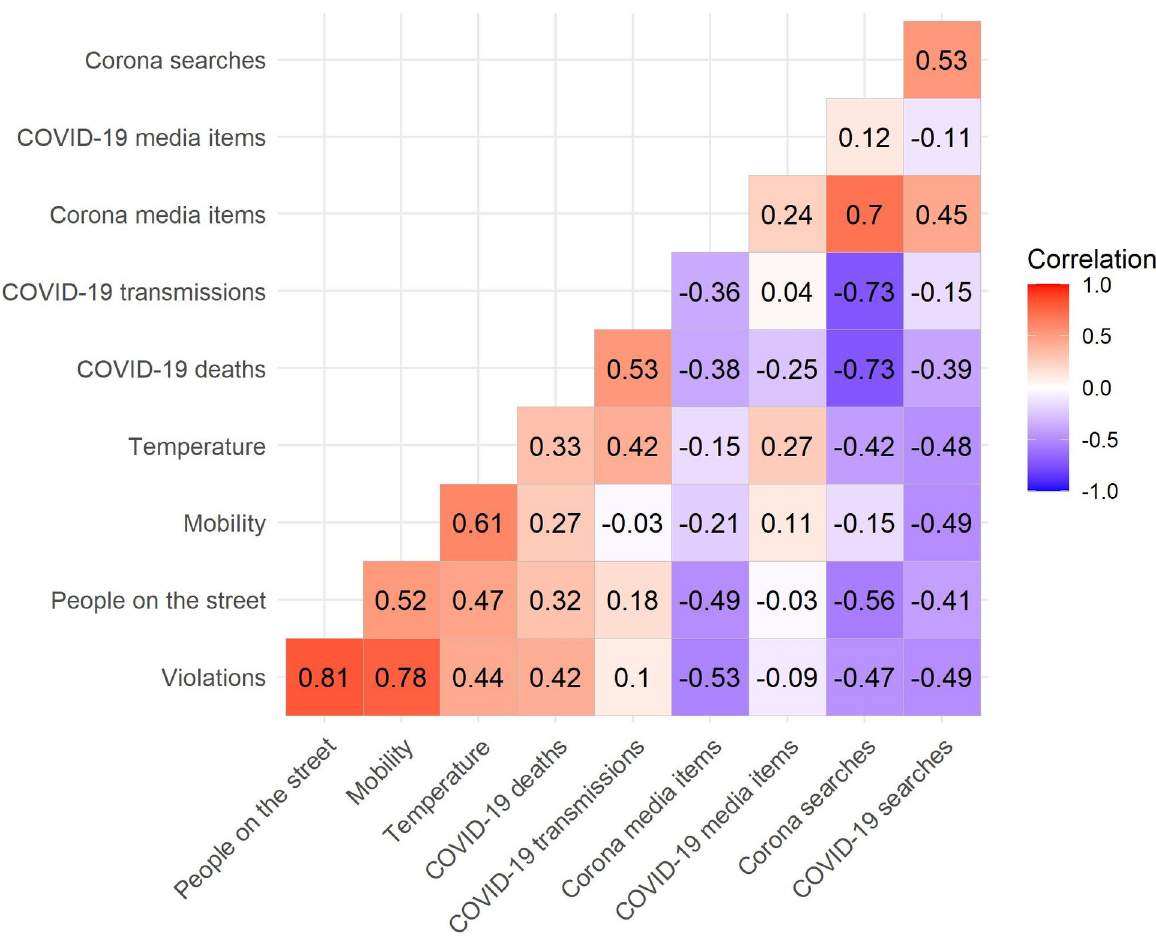
Fig 6. Correlation coefficients between de-trended variables. All variables were de-trended prior to including them in the analyses by taking residuals after OLS-regressing them on time, time squared, and periodicity due to weekday. Time points are Thursdays and Saturdays